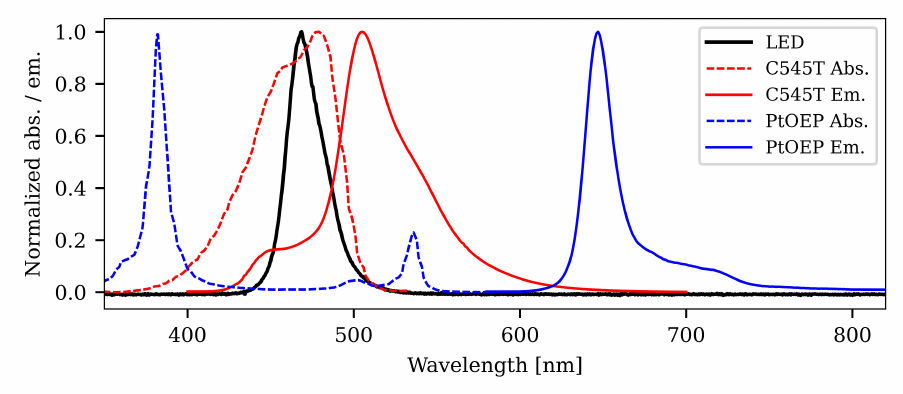
Figure 2. Normalized absorption (dashed lines) and emission (solid lines) spectra of PtOEP (blue) and coumarin 545T (C545T) (red). The LED spectrum is depicted as the solid black